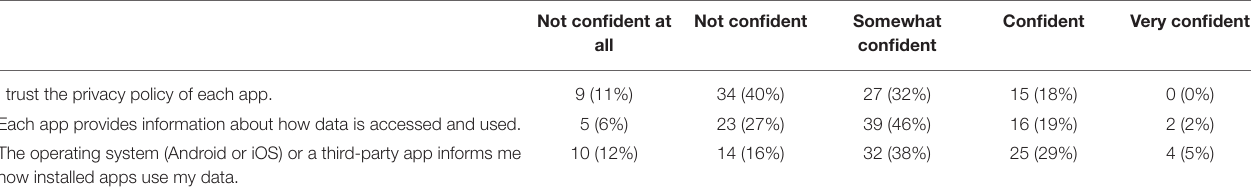
TABLE 9 | Answers to the question “In order to know what data is accessed and by which app, how confident would you be with the following approaches?” ( n = 85).